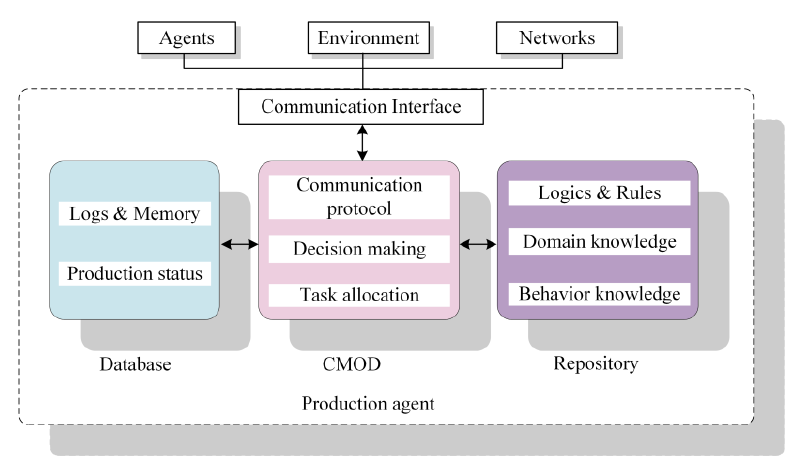
Figure 4. Exemplary structure of collaborative and deliberate agent (CDA).